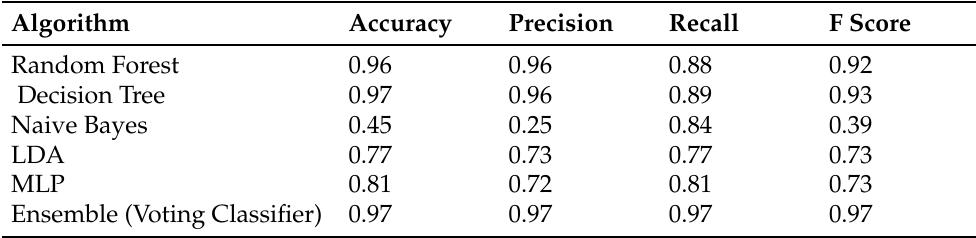
Table 5. Performance comparison of ML